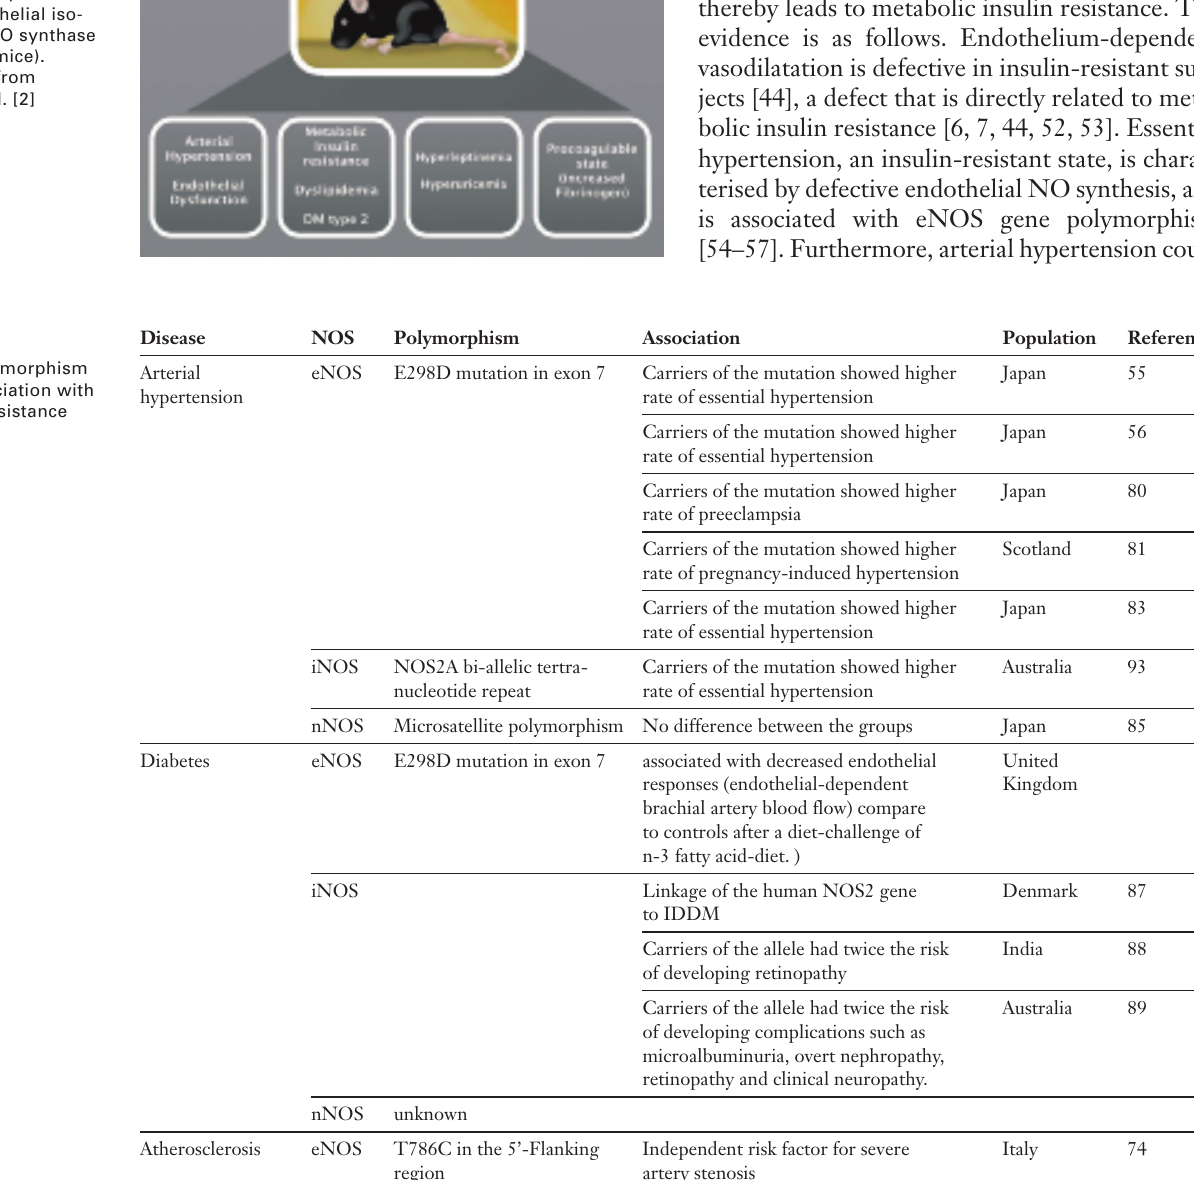
Figure 1 Metabolic phenotype of mice with com- plete disruption of the endothelial iso- form of NO synthase (eNOS –/– mice). Adapted from Cook et al. [2]